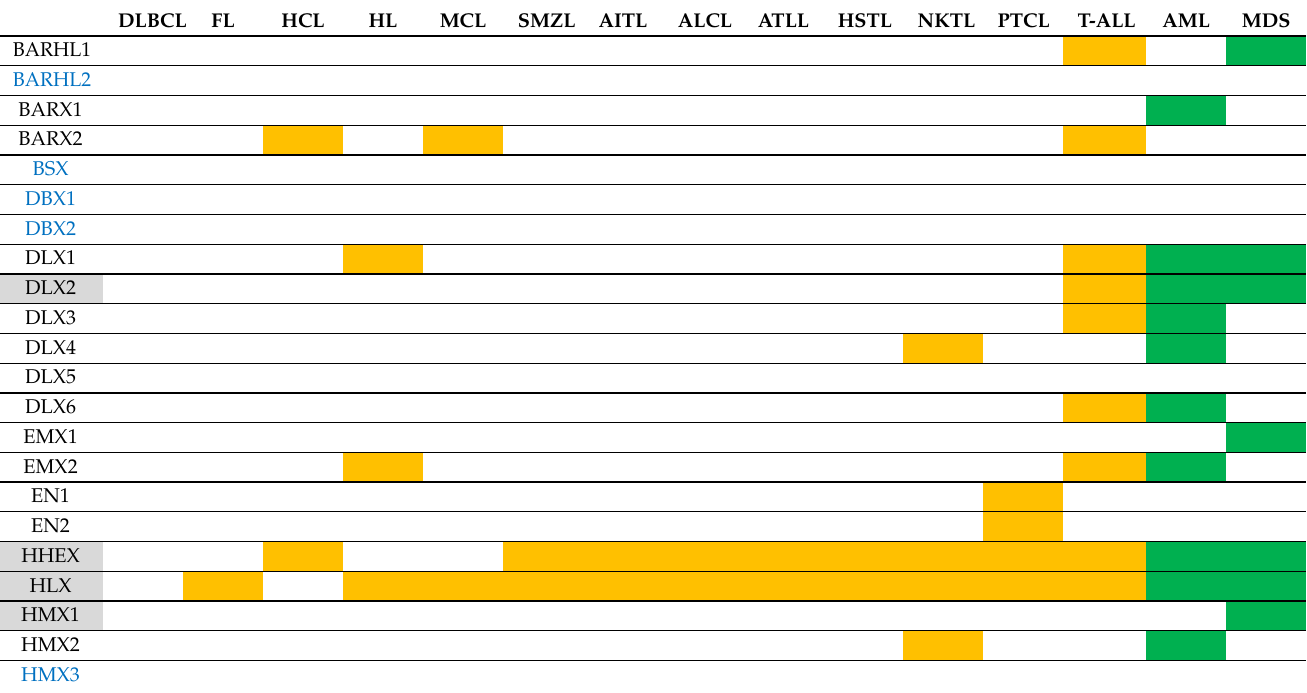
Table 1. Aberrantly expressed NKL homeobox genes in leukemia/lymphoma patients. This table lists all 48 NKL homeobox genes which are deregulated in defined lymphoid and myeloid malignancies (totally 35). NKL-code members are indicated by gray background, genes not represented on the analyzed expression arrays are indicated in blue letters. Lymphoid malignancies are diffuse large B-cell lymphoma (DLBCL), follicular lymphoma (FL), hairy cell lymphoma (HCL), Hodgkin lymphoma (HL), mantle cell lymphoma (MCL), and splenic marginal zone lymphoma (SMZL), angioimmunoblastic T-cell lymphoma (AITL), anaplastic large cell lymphoma (ALCL), adult T-cell leukemia/lymphoma (ATLL), hepatosplenic T-cell lymphoma (HSTL), NKT-cell lymphoma (NKTL), peripheral T-cell lymphoma (PTCL), and T-cell acute lymphoid leukemia (T-ALL). B- and T-cell malignancies are indicated in orange. Myeloid malignancies comprise acute myeloid leukemia (AML) and myelodysplastic syndrome (MDS) and are indicated in